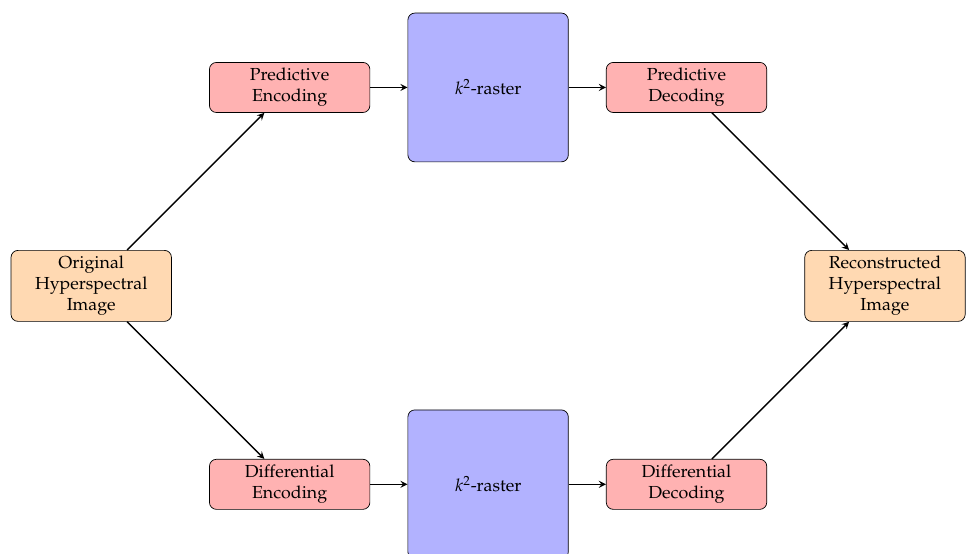
Figure 1. A flow chart showing the encoding and decoding of this